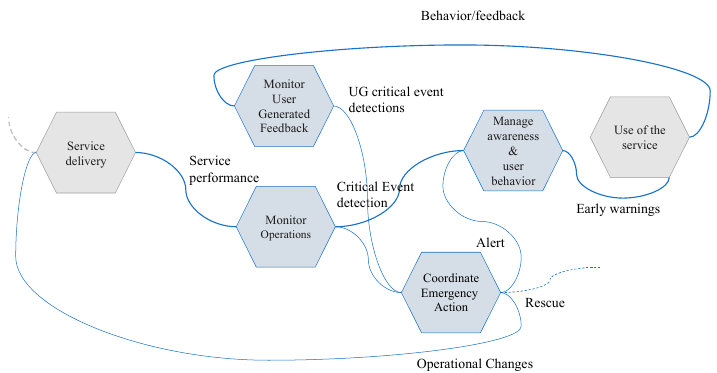
Figure 18. Sub-set of UTS FRAM model.